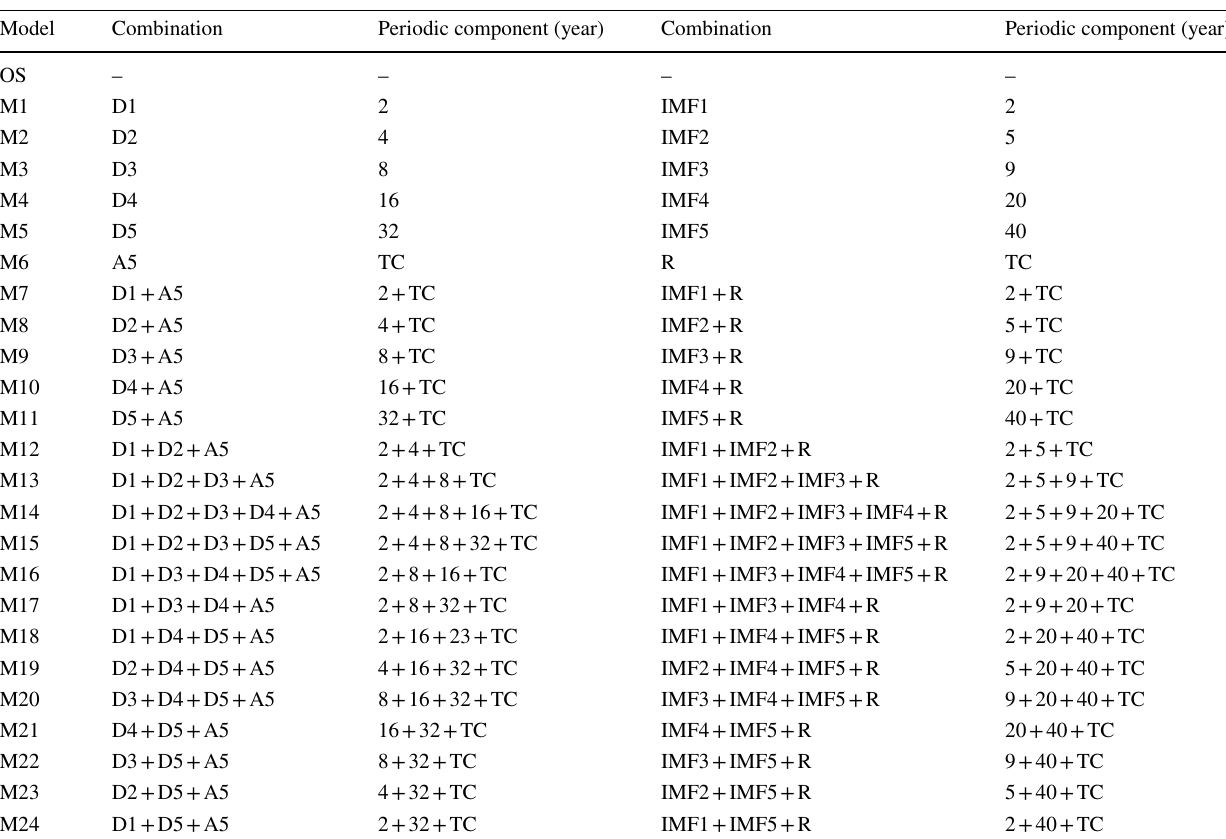
Table 2 The variance with its periodic component for each combined model based on DWT and